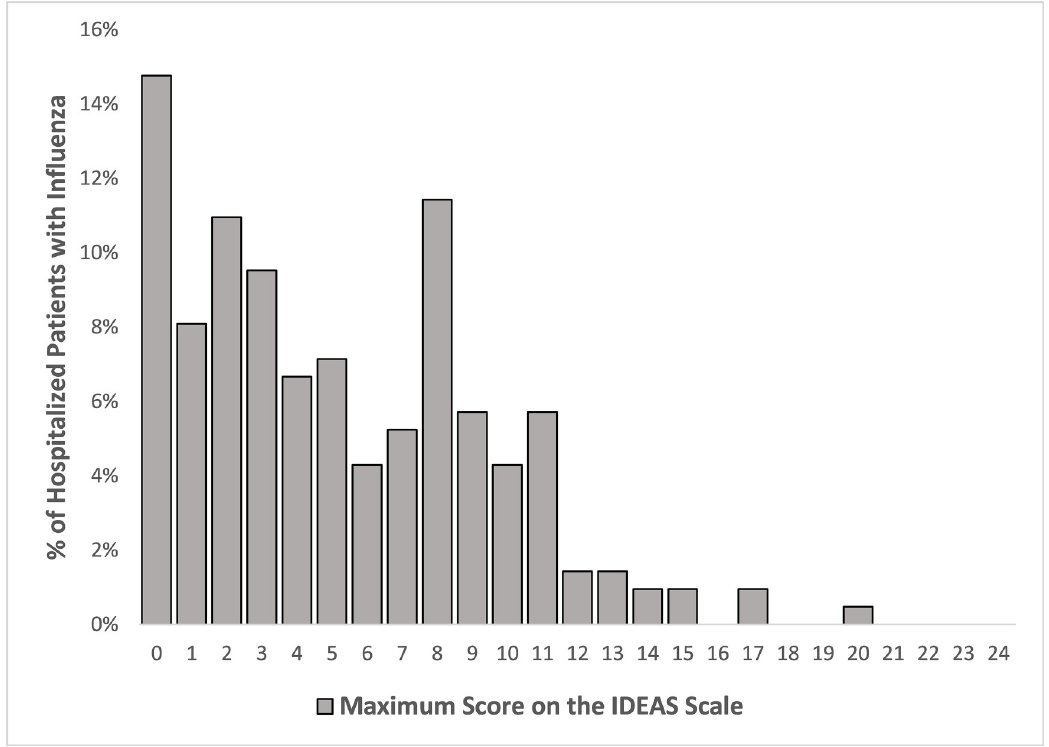
Fig 1. Distribution of hospitalized influenza-positive patients based on the maximum score on the Influenza Disease Evaluation and Assessment of Severity (IDEAS)